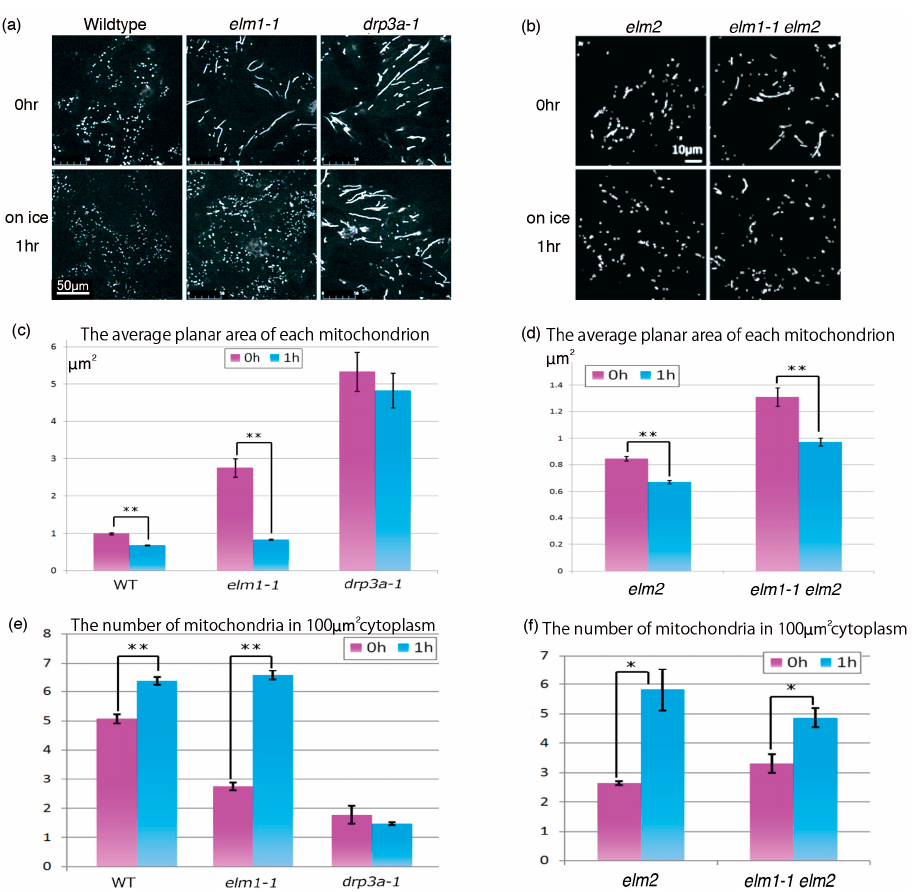
Figure 5. Mitochondrial fragmentation was induced by cold treatment in the wild-type and elm mutants but not in the drp3a-1 mutant. ( a , b ), Representative mitochondrial morphologies in the wild type and mutants at room temperature before and 1 h after 4 °C treatment. Each scale bar is applicable to the all images in ( a , b ), respectively. ( c , d ) Average planar areas of mitochondria in epidermal cells of wild type and mutants before (red bars) and 1 h after (blue bars) cold-temperature treatment ( n > 218 in each of three replications). ( e , f ) Average number of mitochondria per 100 μ m 2 in leaf epidermal cells of wild-type and mutants before (red bars) and 1 h after (blue bars) cold treatment. n = 3 Error bars show S.E. ** indicates statistical significance at p < 0.01 and * at p < 0.05. Because data sets ( a , c , e ) and ( b , d , f ) were collected independently in different conditions (e.g., laser strength, detector gain, etc.), they could not be compared with each other